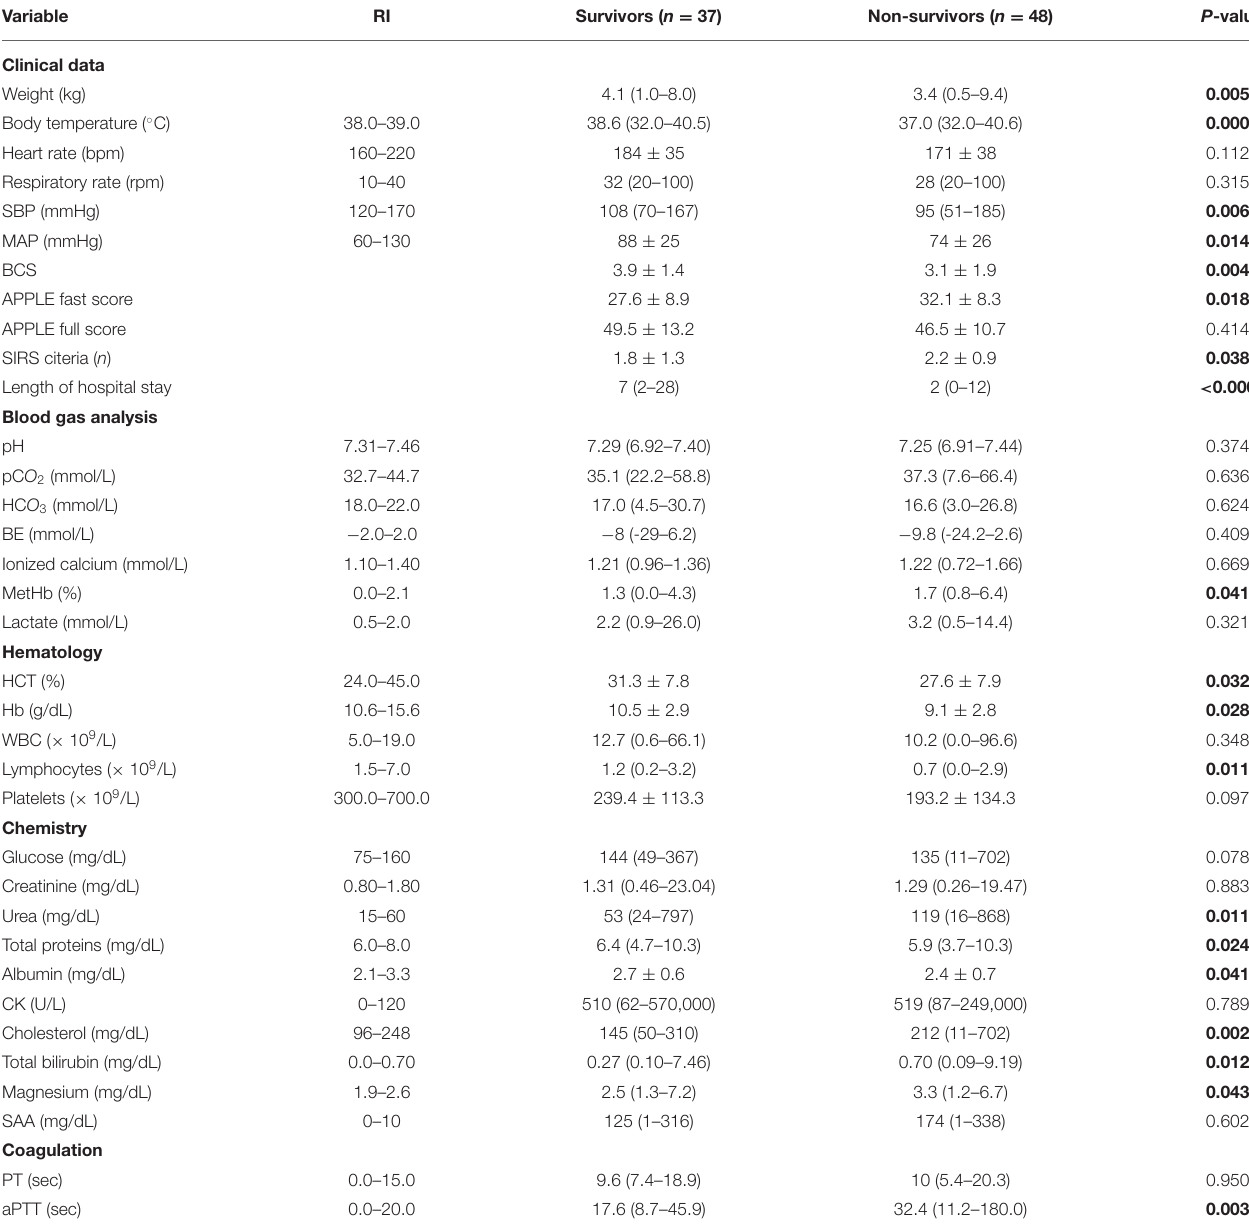
TABLE 4 | Clinical and clinicopathological variables in survivors and non-survivors in the study population.